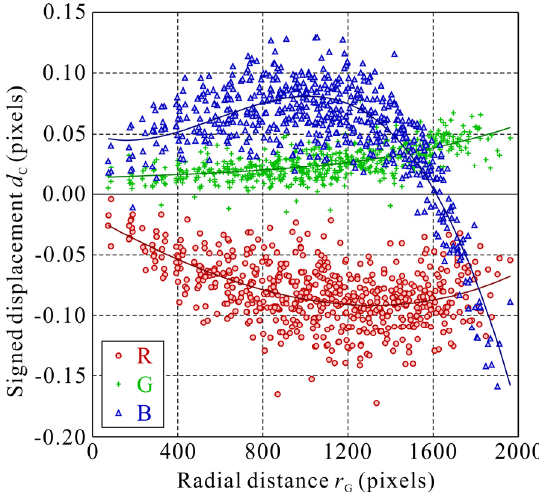
Figure 7. Signed displacements caused by lossy JPEG compression with 2x1 1x1 1x1 sampling